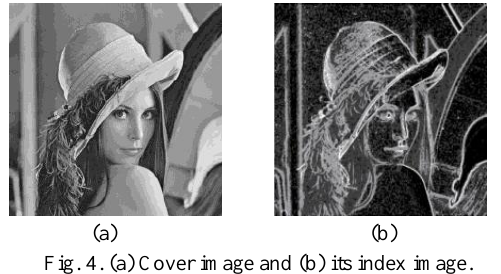
Fig. 4. (a) Cover image and (b) its index